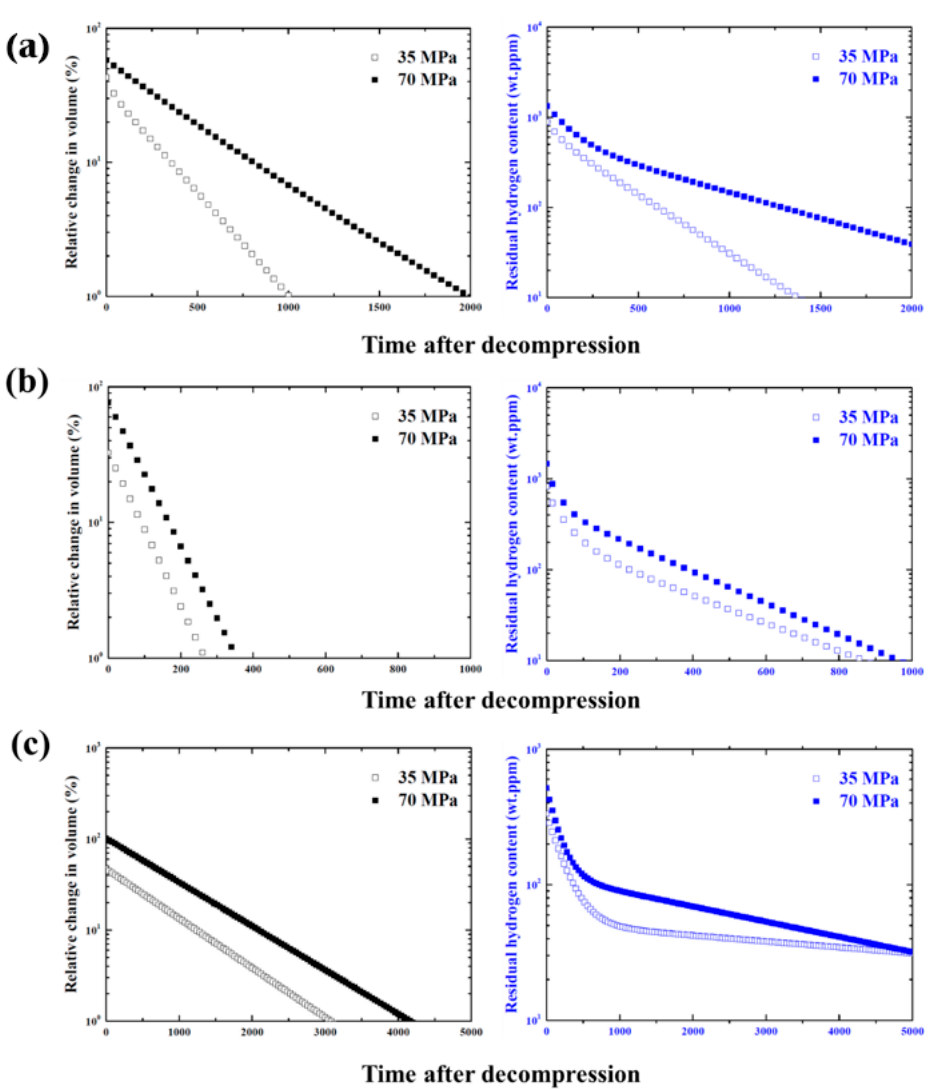
Figure 5. Behavior of volume recovery and desorption of hydrogen. ( a ) NBR, ( b ) EPDM, ( c ) KFM.